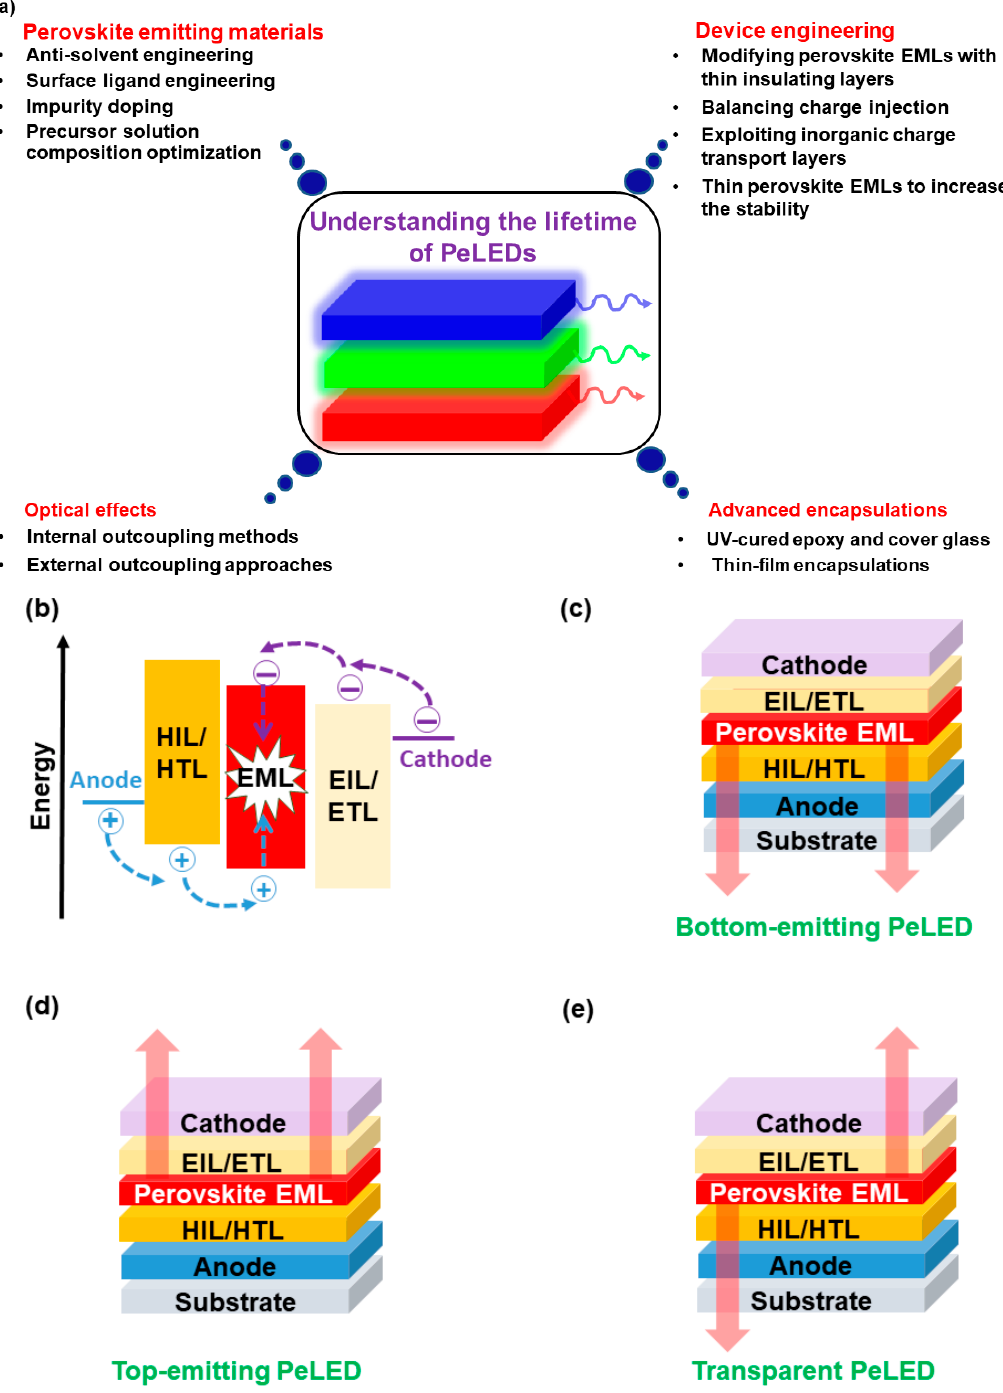
Figure 1. ( a ) Schematic diagram summarizing the main factors to determine the lifetime of perovskite light-emitting diodes (PeLEDs) and corresponding strategies to improve the stability. ( b ) Schematic illustration describing the working mechanism of PeLEDs. ( c ) Device architecture of bottom-emitting PeLEDs. ( d ) Device architecture of top-emitting PeLEDs. ( e ) Device architecture of transparent PeLEDs.